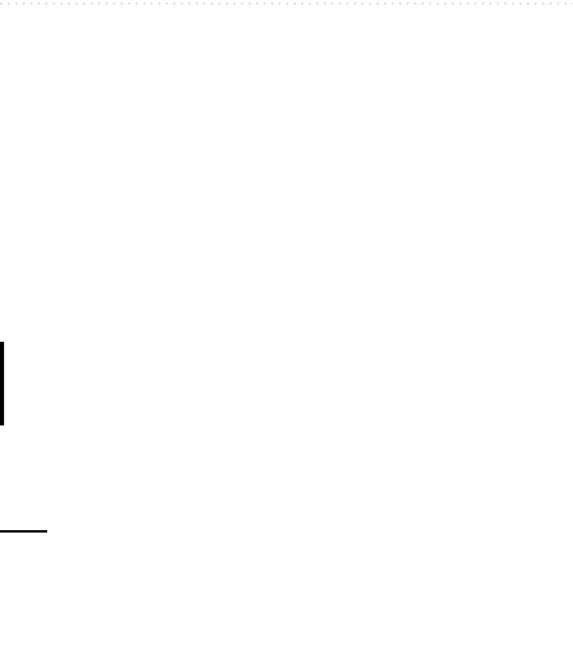
Figure 2. Course of LiMAx values related to TIPS implantation among survivors (N = 23), P = 0.012 (D-1: one day before TIPS; D + 1: one day after TIPS; W4: 4 weeks after TIPS; W12: 12 weeks after TIPS).